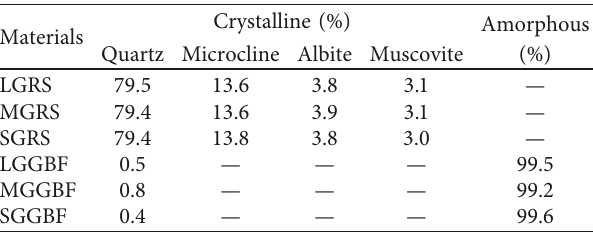
Table 2: Mineralogical compositions of GRS and GGBF